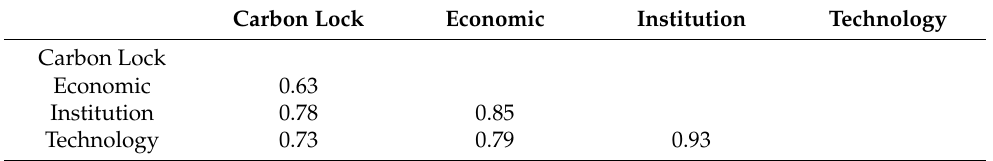
Table 7. Heterotrait–monotrait